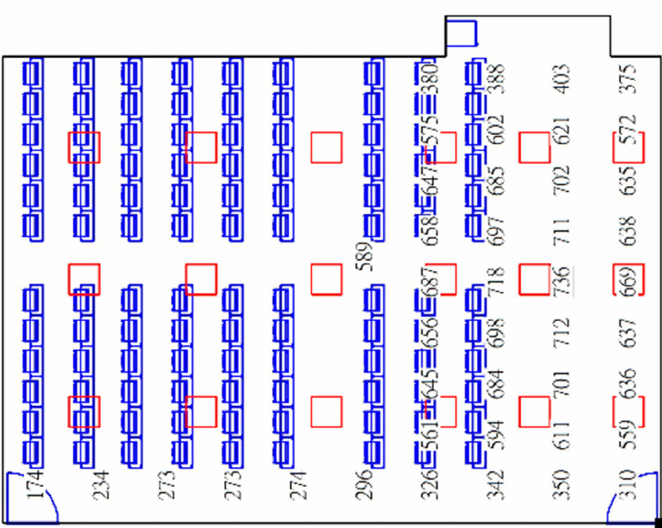
Figure 14. Illuminance distribution after lighting